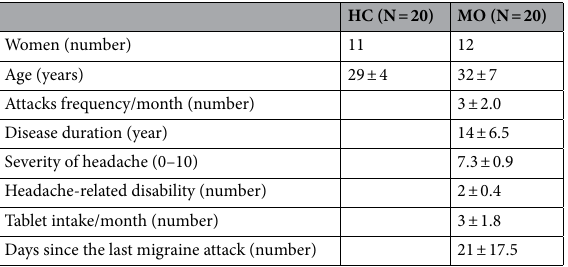
Table 1. Clinical and demographic of healthy controls (HC) and of patients with migraine without aura (MO). Data are expressed as frequency and mean ±